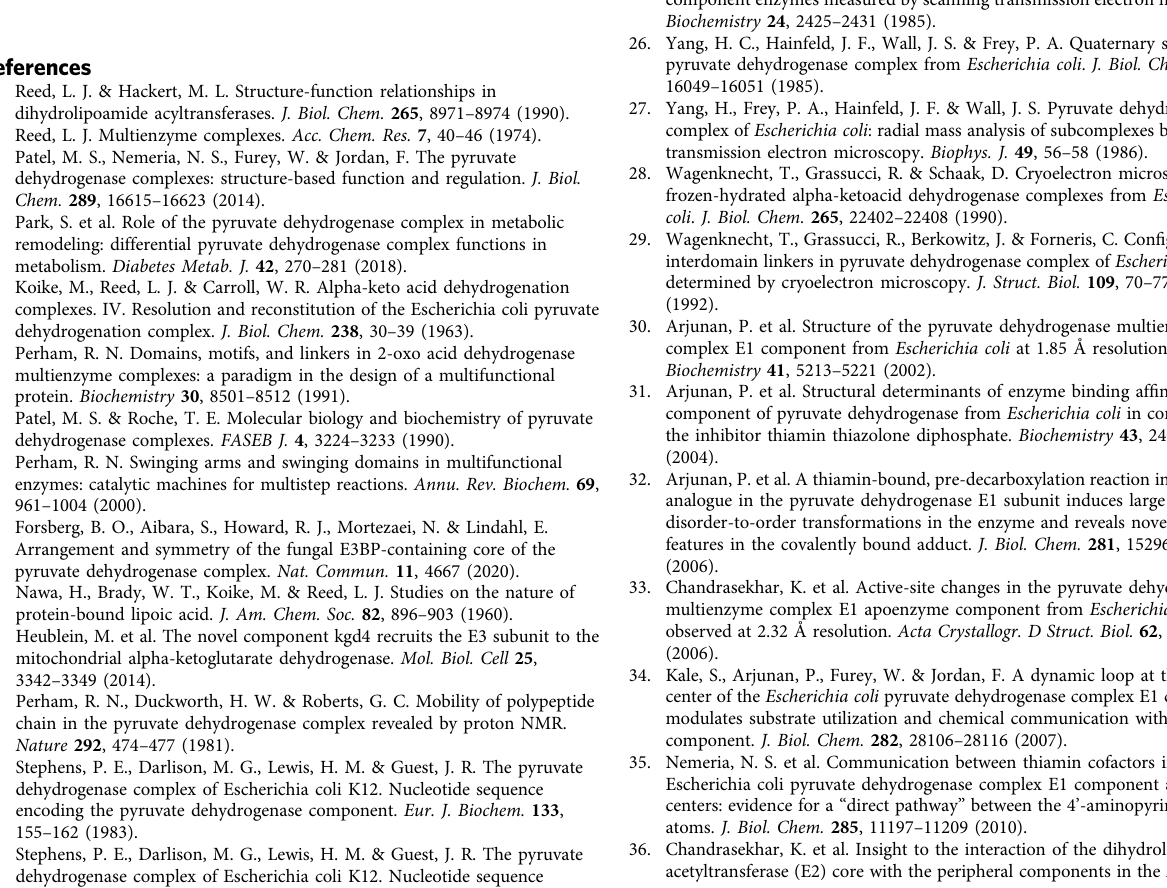
Table 2. The model coordinates and cryo-EM maps were deposited to the Protein Data Bank (accession code 7b9k) and to the Electron Microscopy Data Bank (accession code EMD-12104). For an additional analysis of the whole pyruvate dehydrogenase complex (Supplementary Fig. 4), a box size of 600 px was used for particle extraction, followed by particle down-sampling to a box size of 300 px. A total of 28,674 down- sampled particles were included in the 3D classi fi cation and re fi nement without any symmetry imposed. For the 2D classi fi cation of the outer shell of the pyruvate dehydrogenase complex, a mask covering the E2p core was used for particle subtraction and the subtracted particles (28,674) were 2D classi fi ed to visualize the E1p and/or E3 components. The quality of the fi nal E2p model was evaluated using Phenix version 1.16 92 and the MolProbity server 95 , sequence alignments were made using the Clustal Omega server 96 , the Dali 97 and PISA 98 servers were used for structure analysis, and all structure and volume representation fi gures were created in the PyMOL Molecular Graphics System version 2.2.3 (Schrödinger, LLC) and UCSF Chimera version 1.13.1 99 ,